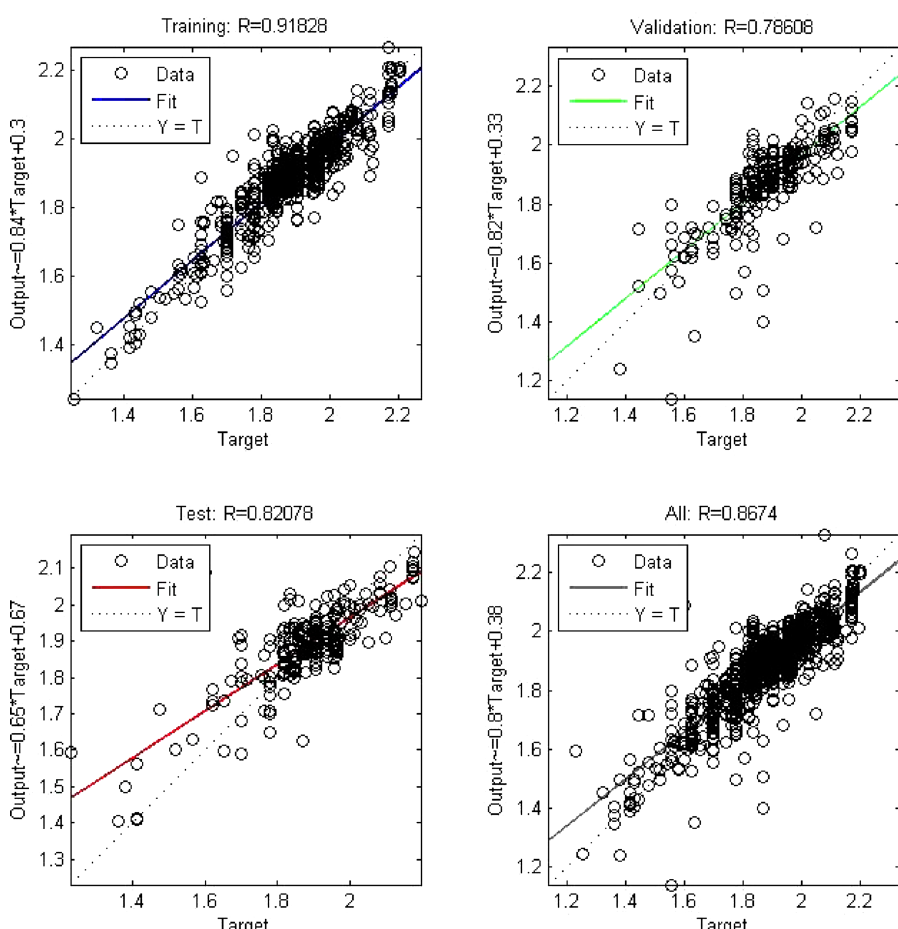
Fig. 6 Correlation coefficient for the trained, the validated, the tested and all